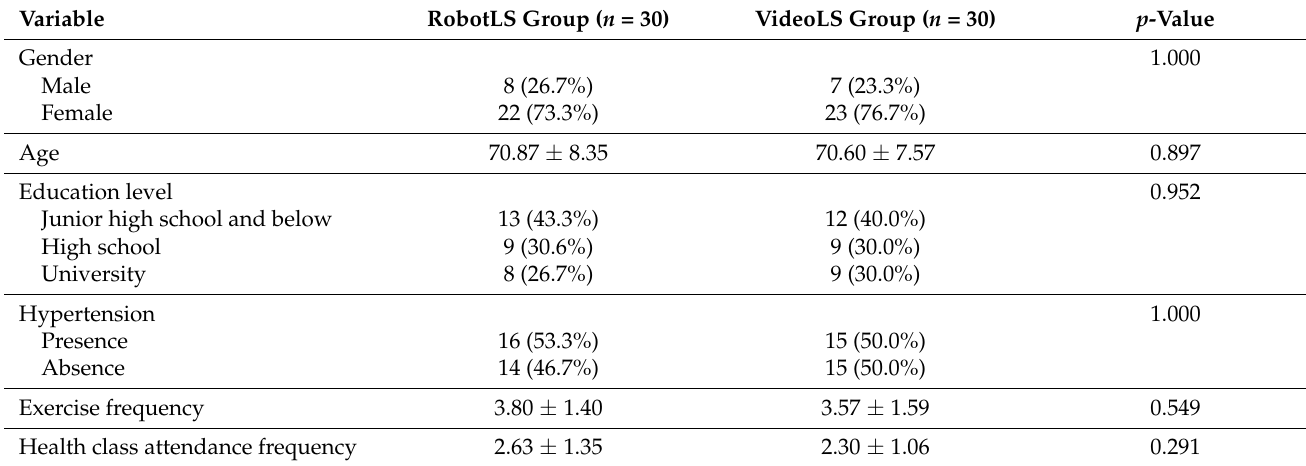
Table 1. Results of demographic variables.